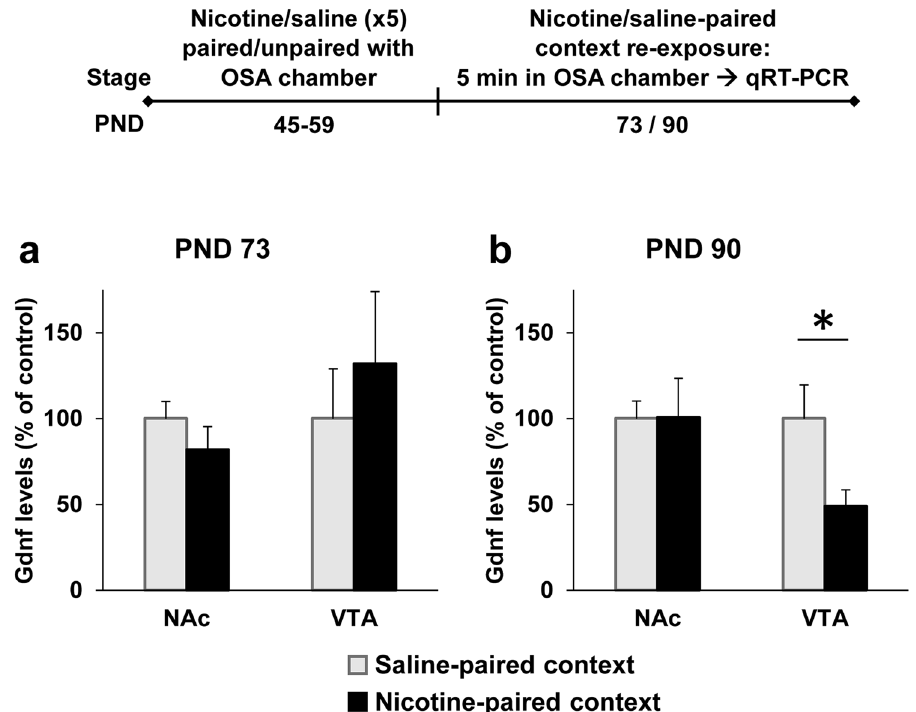
Figure 7. Re-exposure to nicotine-associated context a month after nicotine pre-treatment reduces Gdnf expression in ventral tegmental area (VTA). Rats were treated with 5 nicotine and saline injections on PND 45–59 either in the operant self-administration (OSA) chambers or in a different context. The OSA chambers were paired with nicotine treatment for the Nicotine-paired context group (received saline in a different context), or with saline for the control, Saline-paired context group (received nicotine in a different context). Brains were dissected 30 min after a 5-min re-exposure to the OSA chambers (applying a re-exposure to the nicotine-associated context only for the Nicotine-paired context group, and re-exposure to the saline-paired context for the control group) at the age of PND 73 ( a ) or PND 90 ( b ). Gdnf mRNA expression levels in NAc and VTA were determined by qRT-PCR and normalized to Gapdh . Bar graphs represent means ± SEM. VTA at PND 90: t(11) = 2.47, p < 0.05. All other p’s > 0.05. n = 5–7 per group; * p <